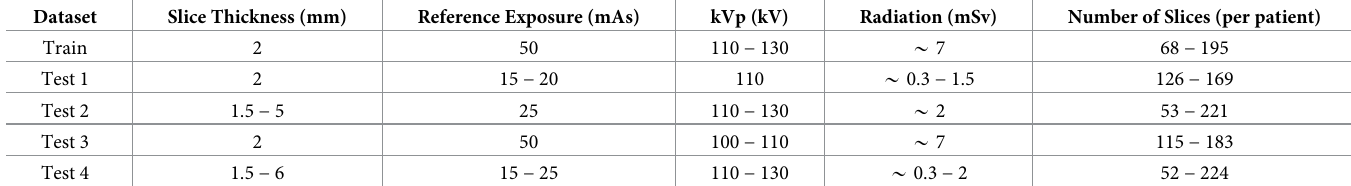
Table 2. Acquisition parameters used to obtain each